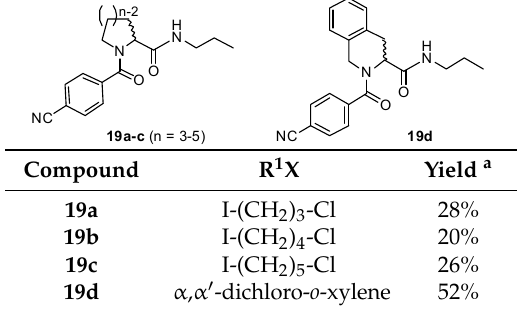
Table 1. Preliminary studies of alkylating agents for the construction of proline (and homologue) rings using BAL-based aldimine resins.